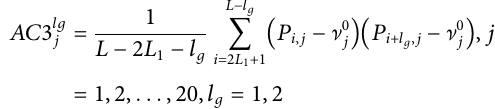
TABLE 2 | Evaluation of model performance after processing unbalanced data by ENN.